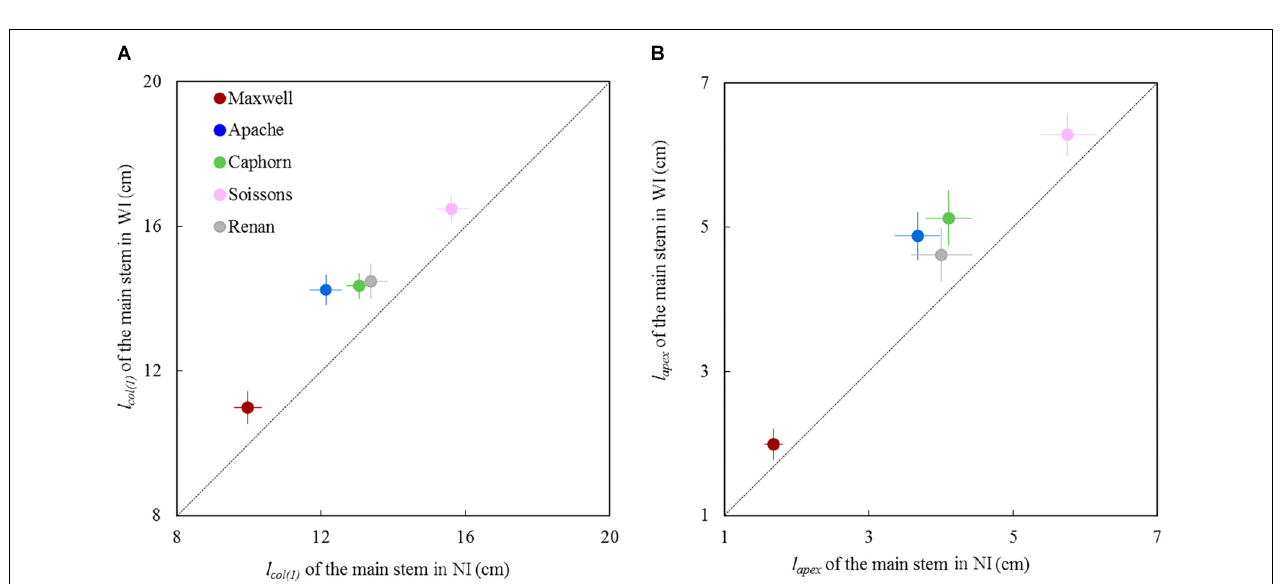
FIGURE 4 | The rate of leaf emergence and the final leaf number of the main stem in WI treatments vs. NI treatments. Each color is associated with a cultivar, as indicated in the legend. The value of the rate of leaf emergence (A) was estimated from a linear model adjusted on the mean estimates of leaf stage. The data for final leaf number (B) are the mean values measured on 10 tagged plants, with error bars representing 95% confidence intervals of mean estimates. The dotted line represents the line 1:1.